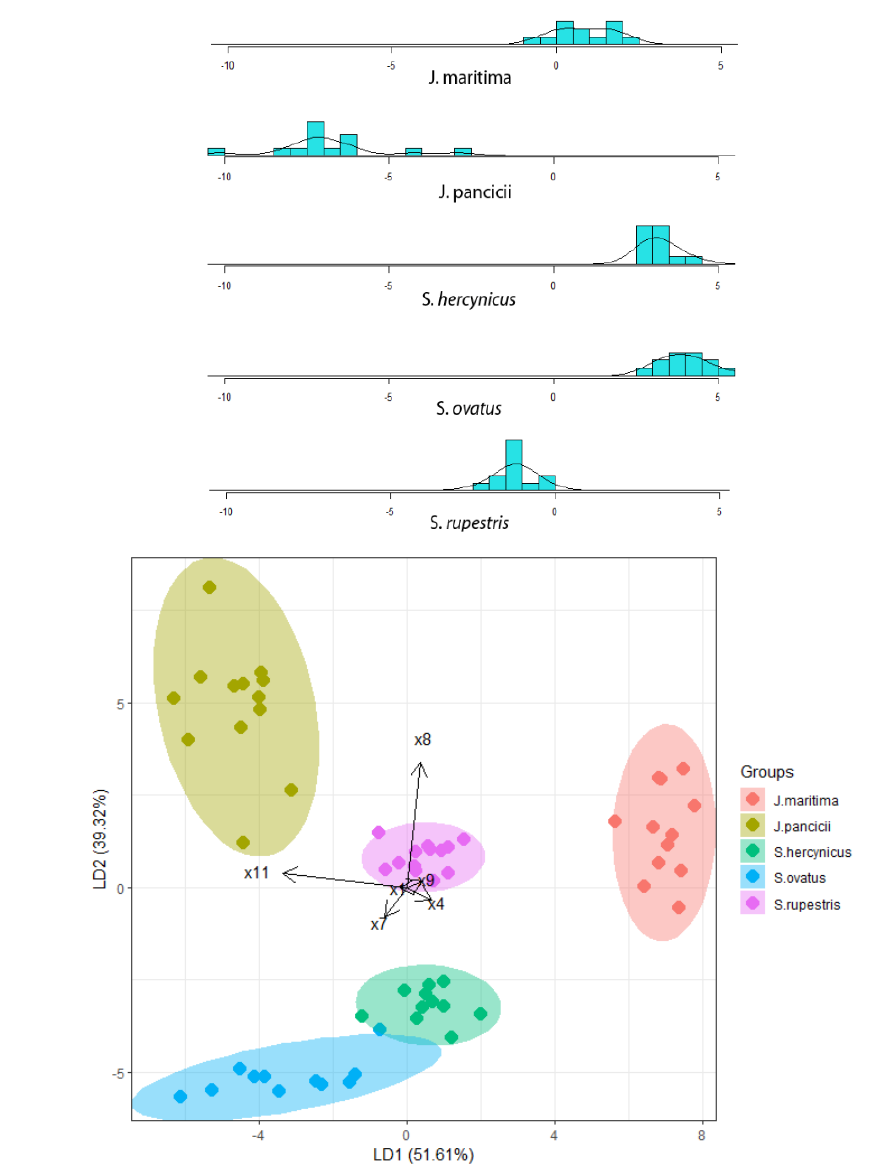
Figure 2. Discriminatory power of LD1 and LD2 functions. ( A )—one-dimensional (1D) and ( B )—two-dimensional (2D) discrimination.